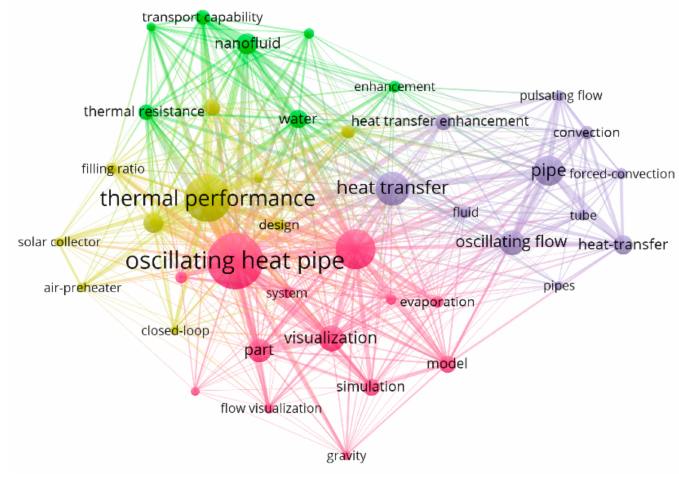
Figure 17. Analysis of each